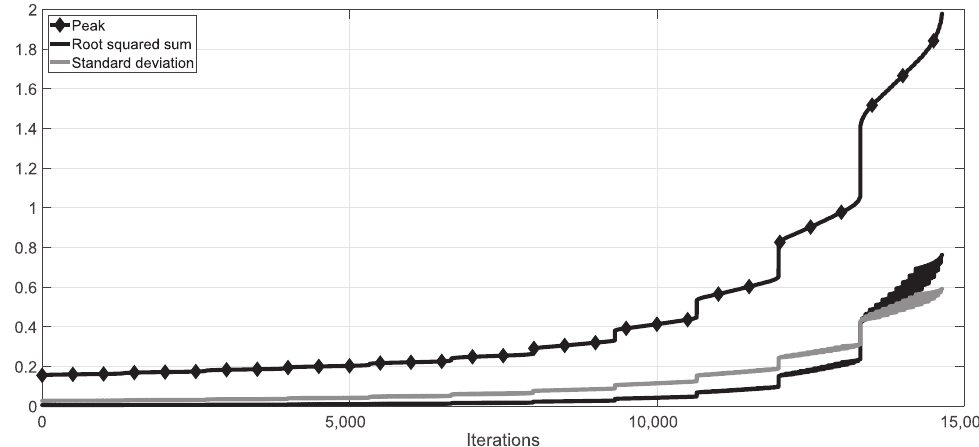
Figure 7. Comparison of different objective functions used in the algorithm. Results for each k i combinations are ordered by peak-risk; the mean-squared error and standard deviation follows the same tendency. The squared peak/maximum criterion is of faster calculation and throws, in practical terms, the same results. Only 10 steps of each k i range are